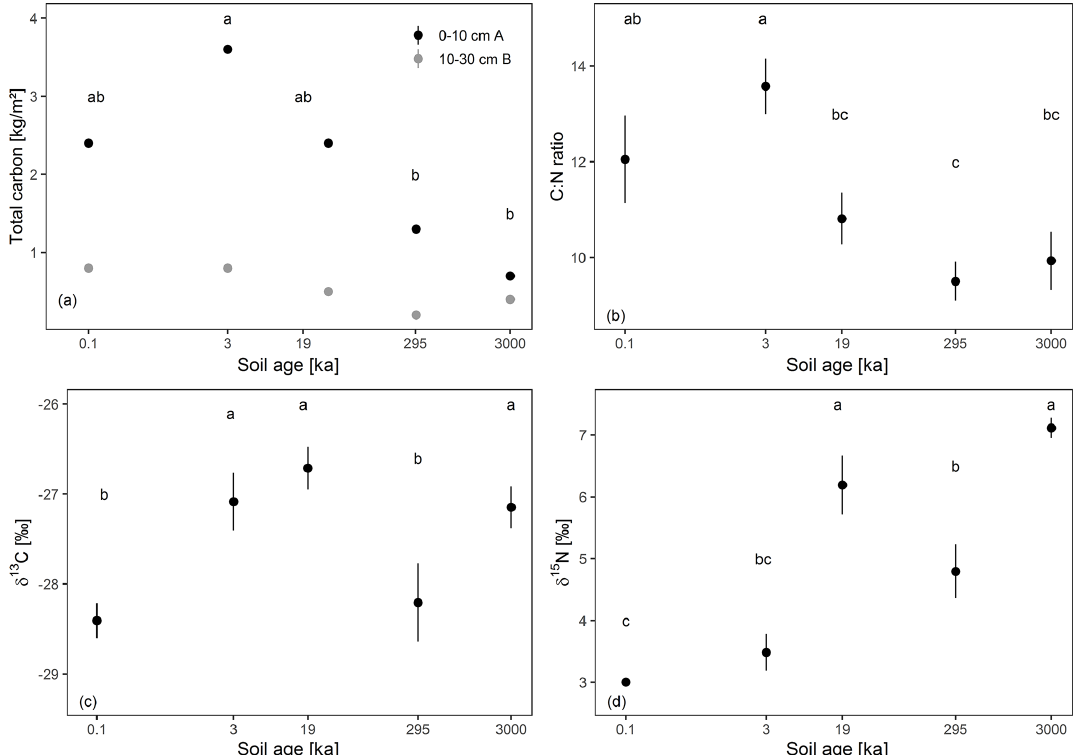
Figure 3. Mean ± standard deviation of site triplicates of total C (a) , the C:N ratio (b) , δ 13 C (c) , and δ 15 N (d) for 0–10 (black) and 10– 30cm soil depth (grey). Significant differences between the soil ages calculated with Tukey’s HSD test are indicated with letters ( p< 0 . 05). Differences across soil age are indicated with lowercase letters and differences across soil depth in capital letters. Soil age is spaced based on the log-transformed age differences.